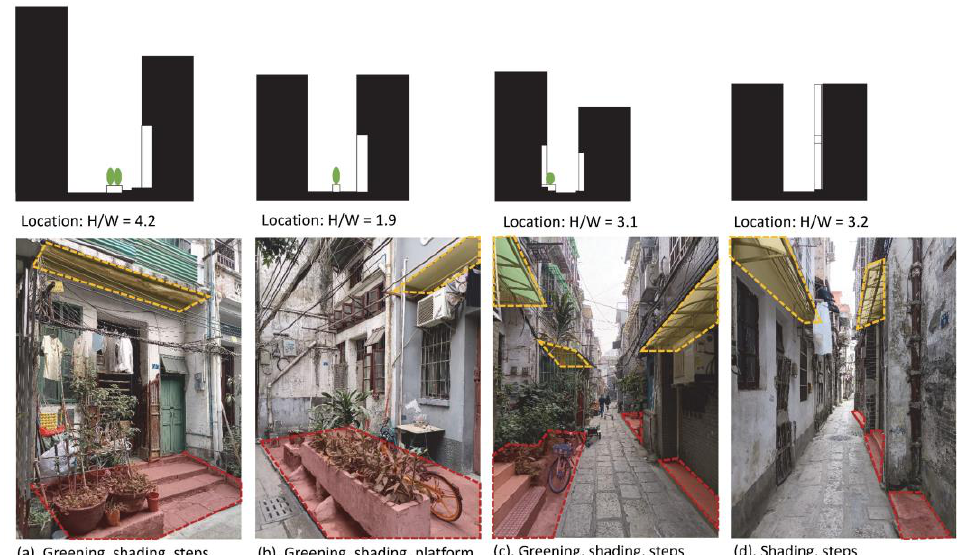
Figure 8. Observations of the in-between spaces in the street (drawn by the students). Windows with overhanging stills, canopies, or railings were also found to be space occupation factors in the street. The scale of the window space was defined as 30–40 cm outside the windows and provided some additional space for storage, plantings, and air- conditioner installations as well. Furthermore, blinds or movable shading devices provided a controllable sight line between the street and the indoor space, intensifying the adaptive relationship between the public and the